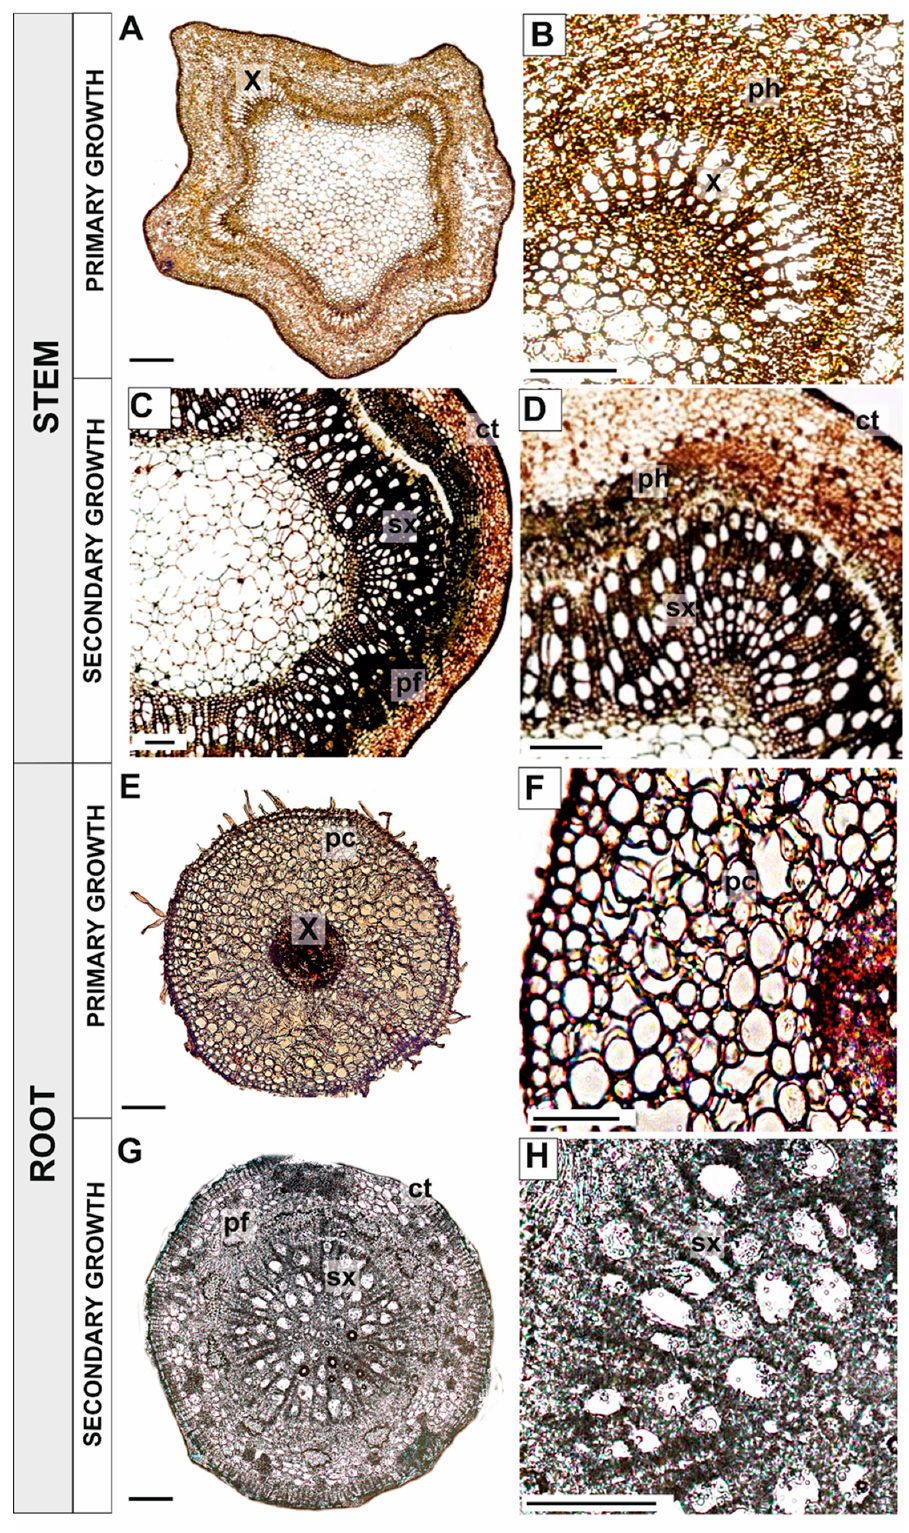
Figure 5. Localization of hydrogen peroxide (orange polymer) in the stems of black cottonwood ( Populus trichocarpa ) with primary growth ( A,B ), secondary growth ( C,D ), and in pioneer roots with primary growth ( E,F ), secondary growth ( G,H ). (Abbreviations: x—primary xylem, sx—secondary xylem, ph—phloem, pf—phloem fibres). Bars = 100 μ m.